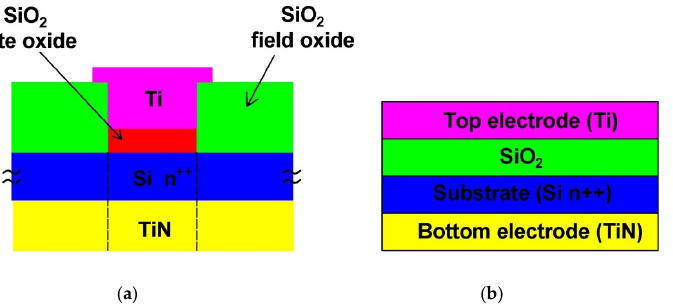
Figure 4. ( a ) Cross-sectional view of Ti/SiO 2 /Si(n ++ )/TiN Memristor. ( b ) Schematic of Metal-Insulator-Metal (MIM) structure.